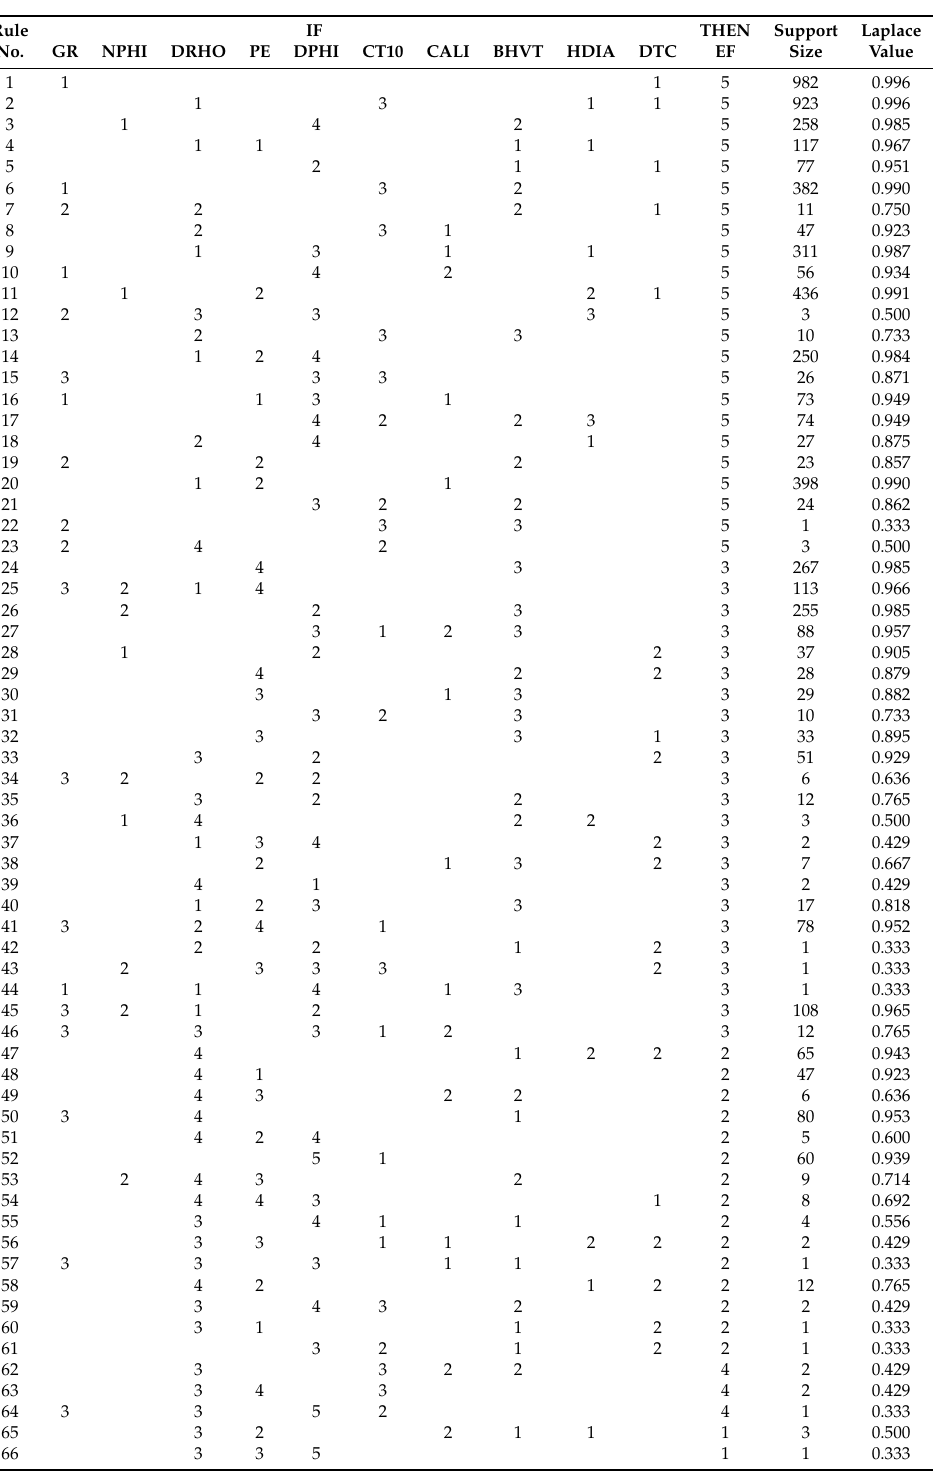
Table 3. Rules generated by Rough Set